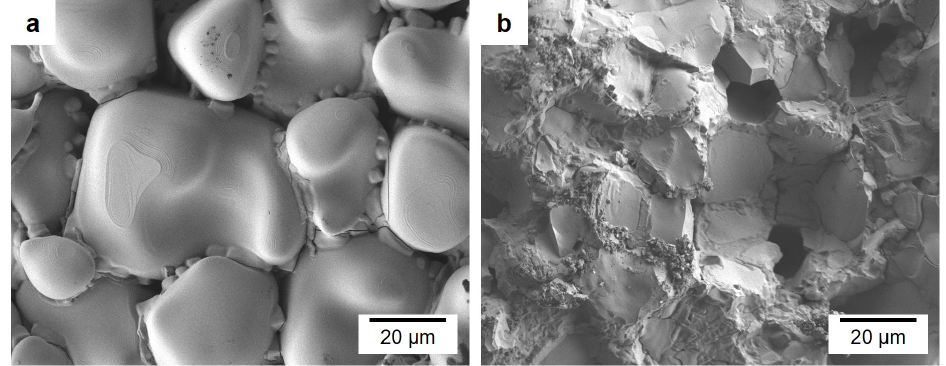
Figure A6. SEM images of Pr 0.3 Sr 0.7 (Cr,Mn,Fe,Co,Ni)O 3– δ membrane: ( a ) surface; ( b ) cross-section.